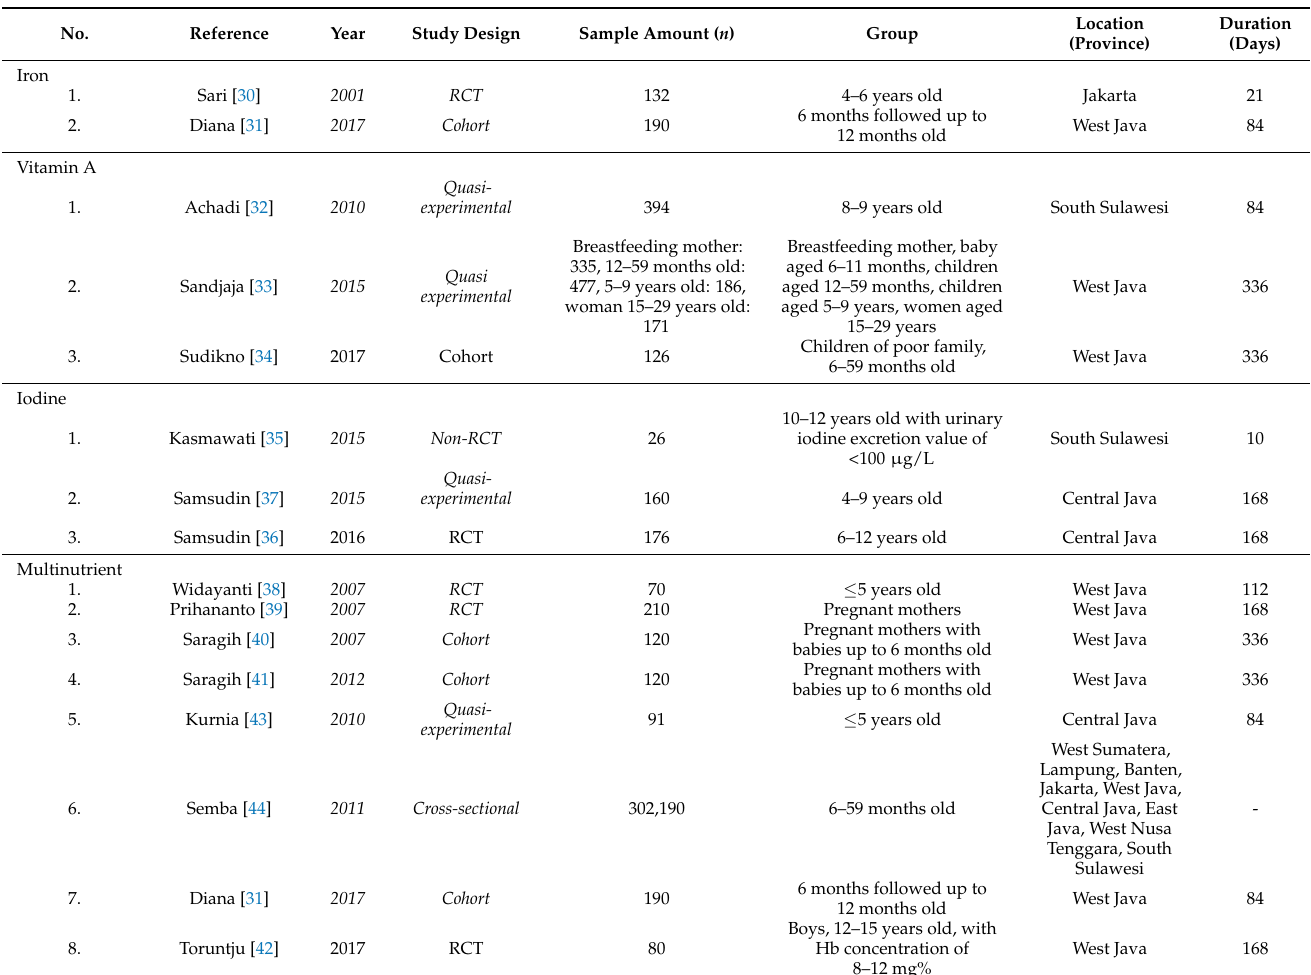
Table 1. Studies on the relationship between food fortification and nutritional status.